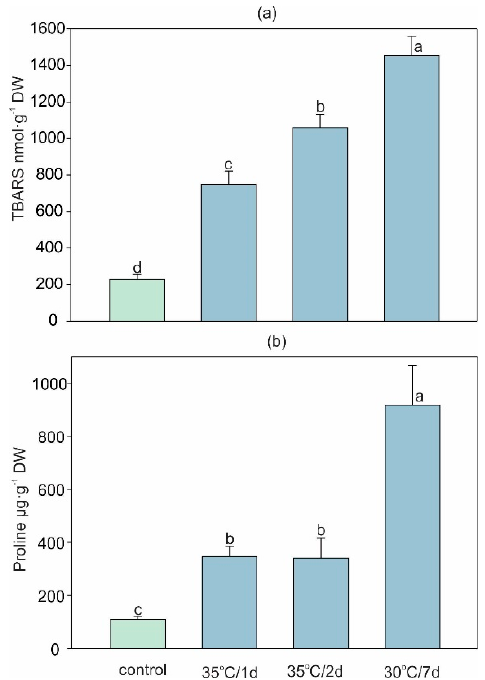
Figure 3. Changes in ( a ) the level of lipid peroxidation expressed by the thiobarbituric-acid-reactive substances (TBARS) content and ( b ) free proline content in leaves of H. sosnovskyi in response to heat stress. Data are means ± SE ( n = 4). Values followed by the same letter(s) are not significantly different according to Tukey’s test ( p < 0.05).